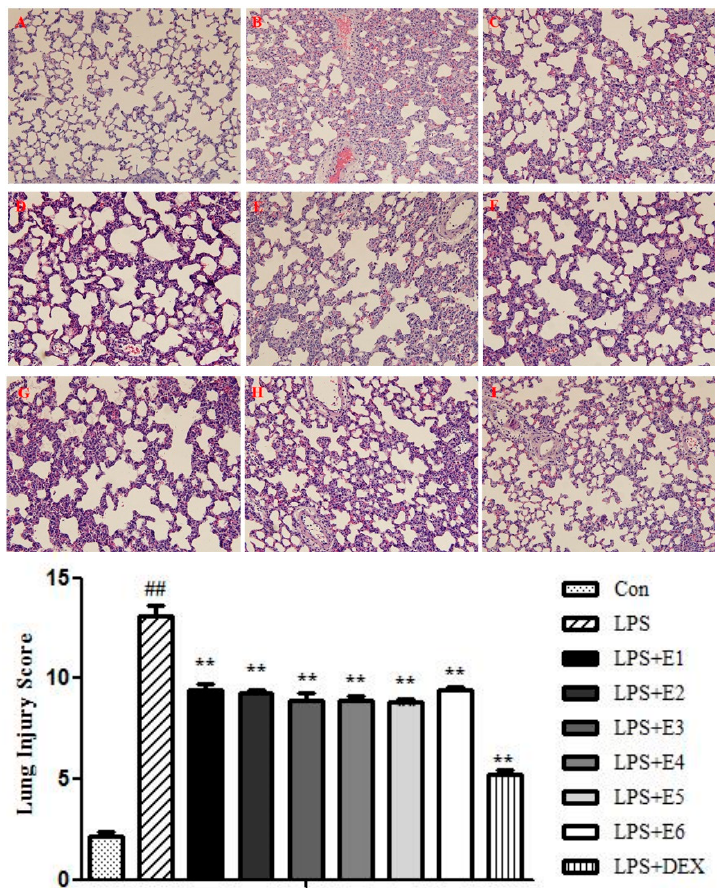
Figure 4. Extracts of QBD ameliorated LPS-induced histological changes in the lung. After